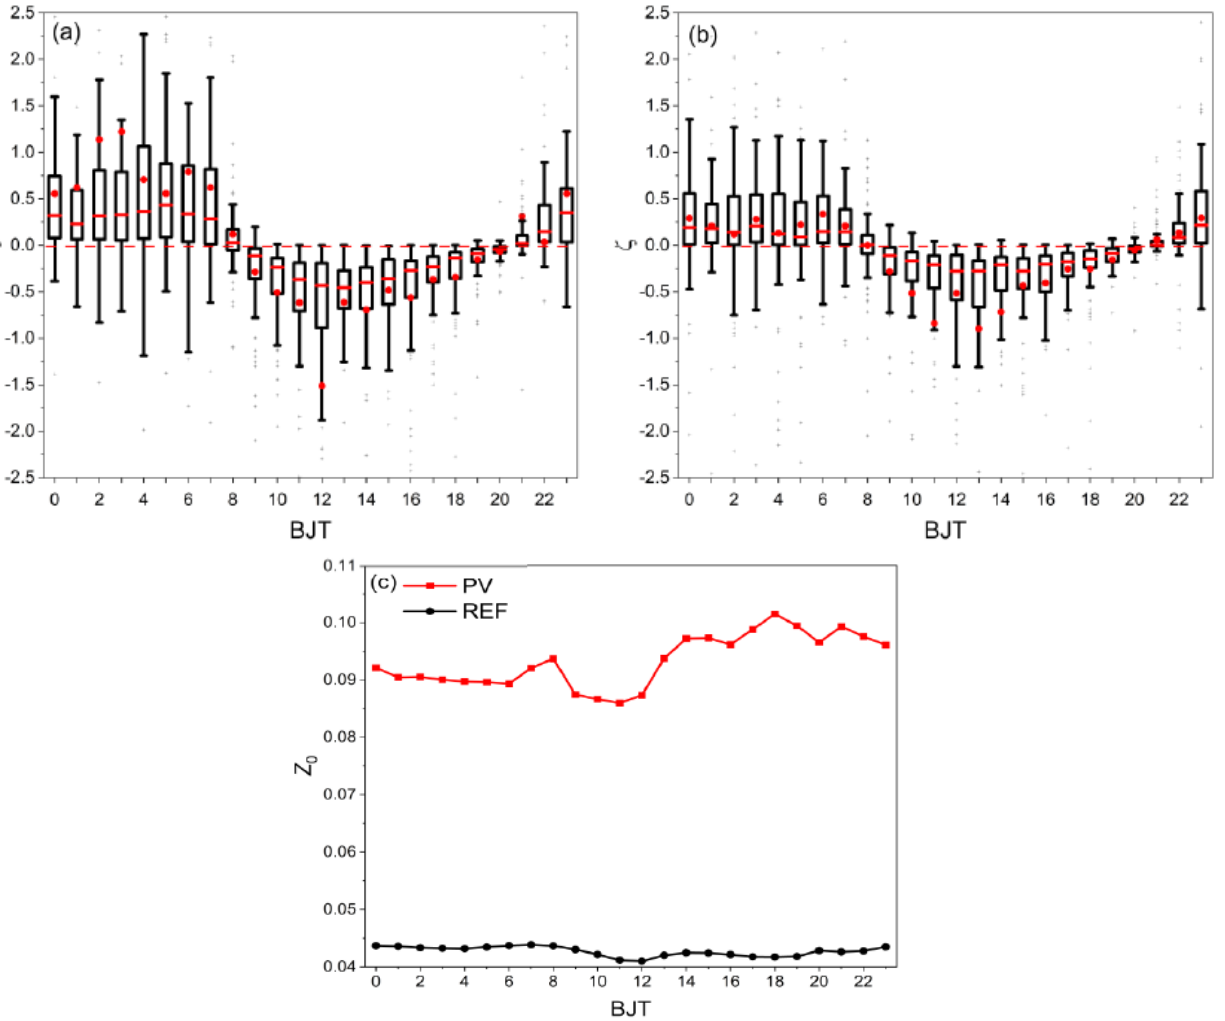
Figure 2. Diurnal variation of the atmospheric stability parameter ζ in the PV plant ( a ) and the reference site ( b ). The height of the box shows the range from the 25th to 75th percentile. The horizontal red line inside the box and solid red dot denote the median value and mean value, respectively. The ends of the whiskers are drawn to the 10th and 90th percentile values. ( c ) is the diurnal variation of aerodynamic roughness Z 0 in the PV plant (red line) and the reference site (black line). BJT is for Beijing time.